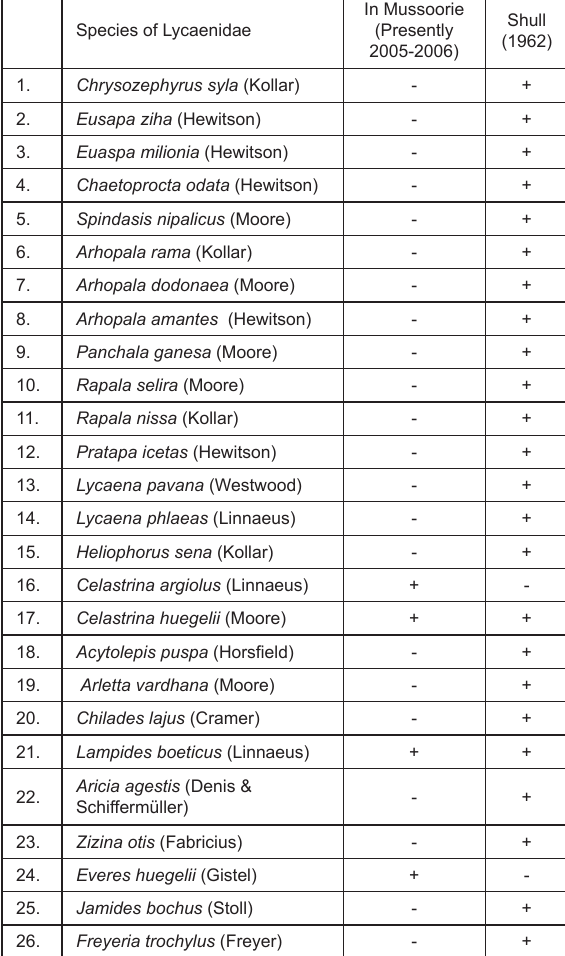
Table 2. List of lycaenids recorded from Bhilaru Pumping Station in a single day by Schull (1962) and the present survey between 2005 and